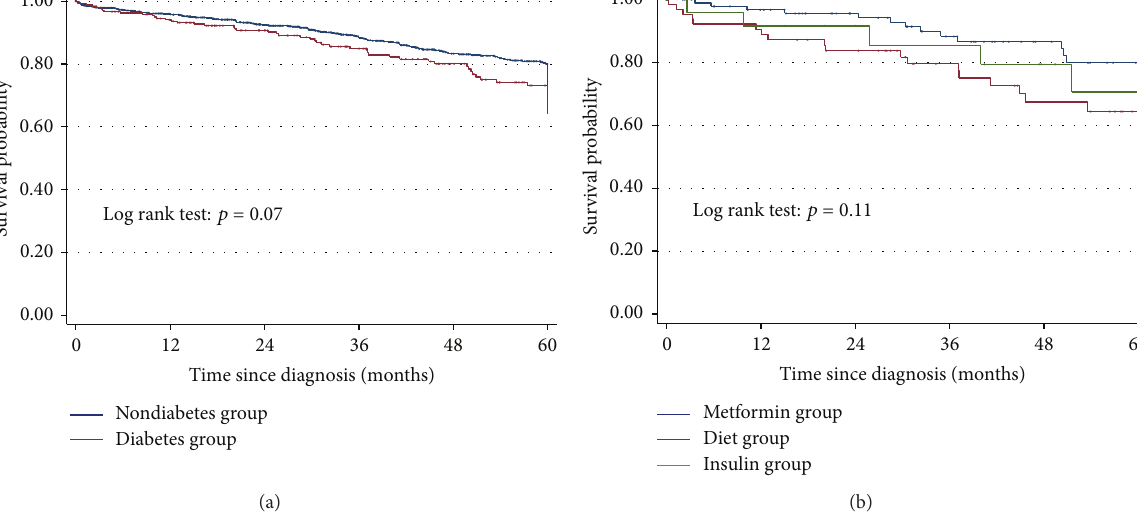
Figure 3: (a) Overall survival of diabetes and nondiabetes stage II colon cancer patients. (b) Overall survival of diabetes patients comparing diet alone group ( 𝑁 = 67 ) versus metformin group ( 𝑁 = 99 ) versus insulin group ( 𝑁 = 24